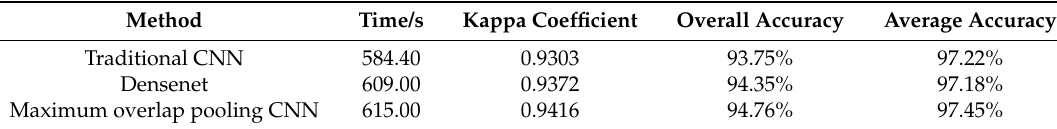
Table 6. Convergence time and accuracy of different classification methods used Salinas